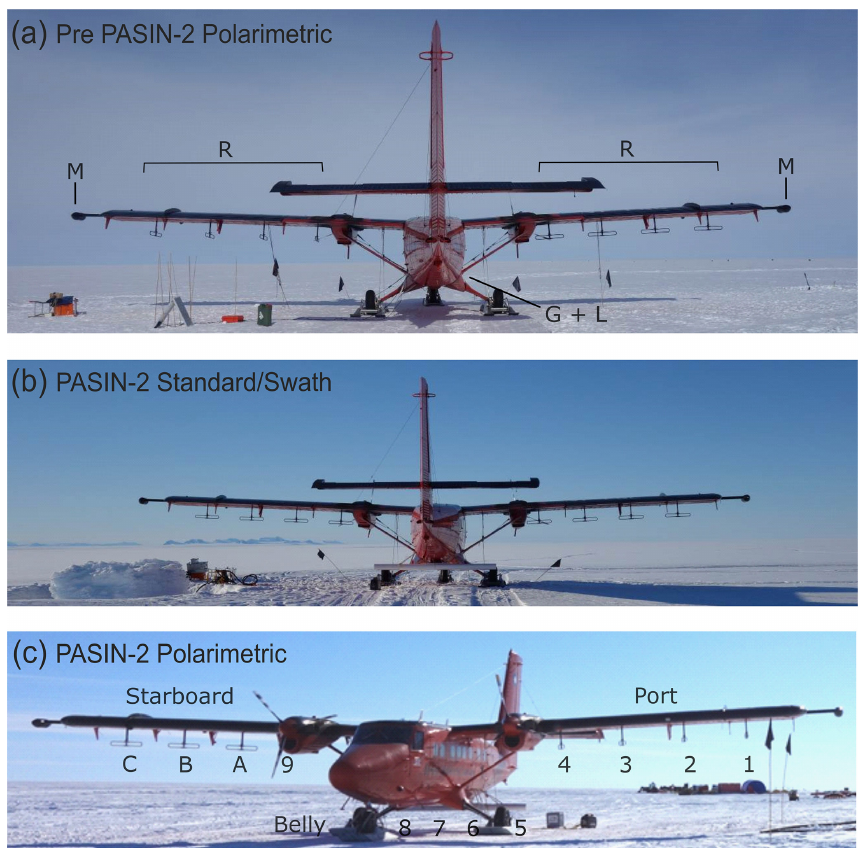
Figure 5. Photographs of the aerogeophysical set-up on the BAS Twin Otter aircraft “ VP-FBL ” for PASIN-2. (a) The pre-PASIN-2 (used in 2015–2016 PolarGAP only) configured to mimic the set-up of PASIN-1 data collection in polarimetric mode. The eight folded dipole transmitting and receiving antennas are fixed under the wings (two transmitting and two receiving antennas on each wing) with the port configured as vertical (V) and starboard as horizontal (H). The annotations show the location of the radar (R), magnetic (M), and gravity and lidar (G + L) instruments on board the aircraft. (b) The PASIN-2 set-up in standard/swath mode. The eight folded dipole transmitting and receiving antennas are fixed under the wings and inside the aircraft and are operated using a radio frequency (RF) switch, and an additional four receiving antennas are situated in the belly enclosure. When in standard swath mode, all antennas are configured in H orientation with the starboard and belly antennas also in H orientation. The PASIN-1 set-up in standard mode (not shown here) had a similar configuration as shown in (b) bar the belly antenna (i.e. only four transmitting on port and four receiving on starboard in H orientation). (c) The PASIN-2 set-up in polarimetric mode. The eight folded dipole transmitting and receiving antennas are fixed under the wings and inside the aircraft and are operated using an RF switch, and an additional four receiving antennas are situated in the belly enclosure. When in polarimetric mode, the port antennas are configured in V orientation and the starboard and belly antennas in H orientation. The PASIN-1 set-up in polarimetric mode (not shown here as rarely flown) had the two pairs of outboard antennas rotated to V configuration and the inboard to H configuration. Photo credit: Carl